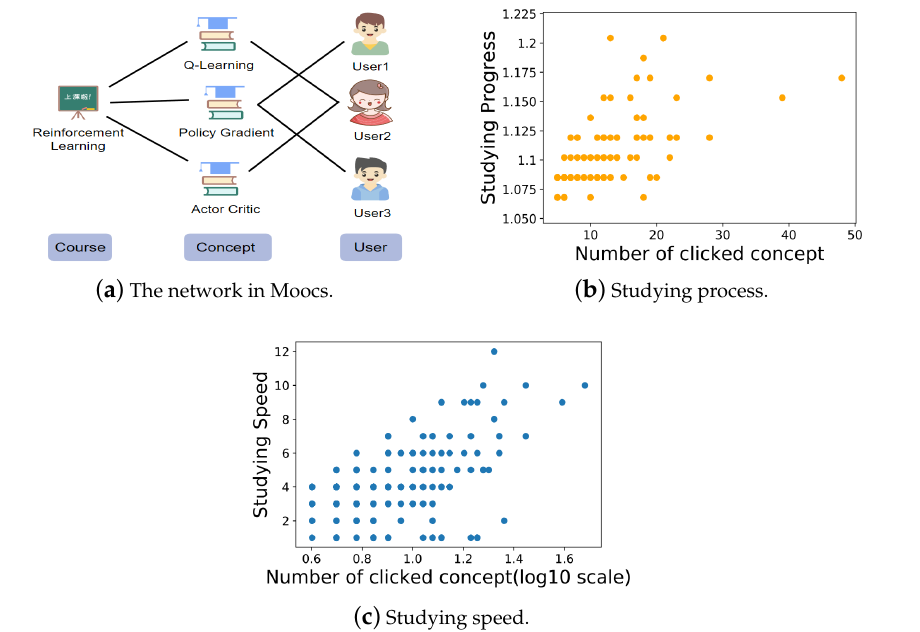
Figure 1. An illustration of concept recommendation. ( a ) The network in MOOCs. ( b , c ) The correlation between the number of clicked concepts and the progress as well as speed of studying, respectively.